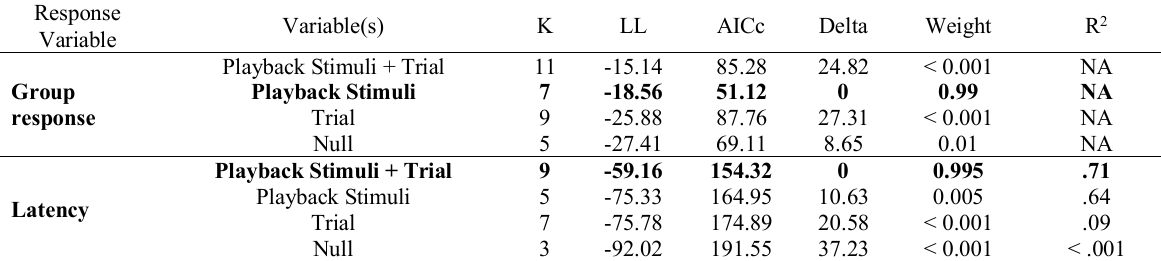
AIC Model Selection Results for the Effects of Playback Stimuli on Group Response and Latency Response Variable